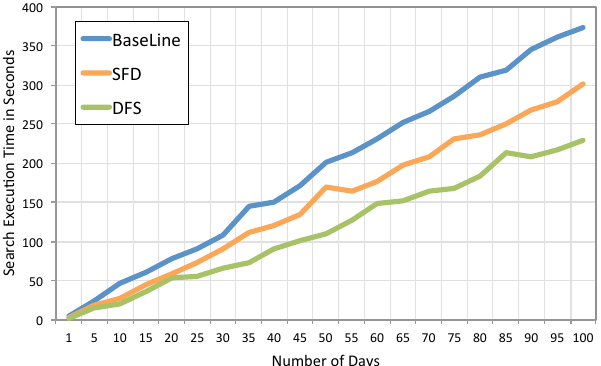
Figure 10. Search execution time for three different proposed data